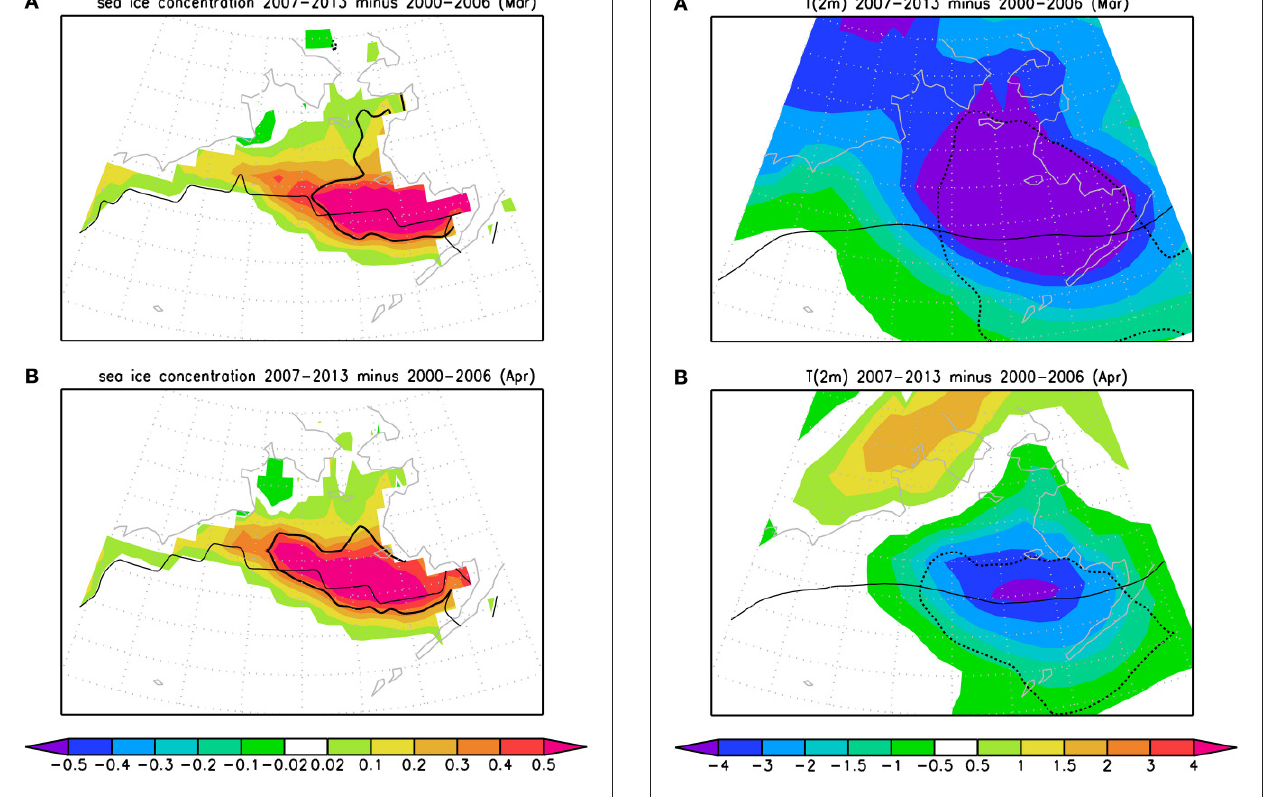
FIGURE 2 | Difference of sea ice concentration (100%) in March (A) and April (B) derived as mean during 2007–2013minus that during 2000–2006 based on HadISST data. Thin lines denote the south edge of mean sea ice based on the period 2000–2006. The thick lines denote that the difference between 2007–2013 and 2000–2006 is significant at the 99% confidence level according to the Student t -test.